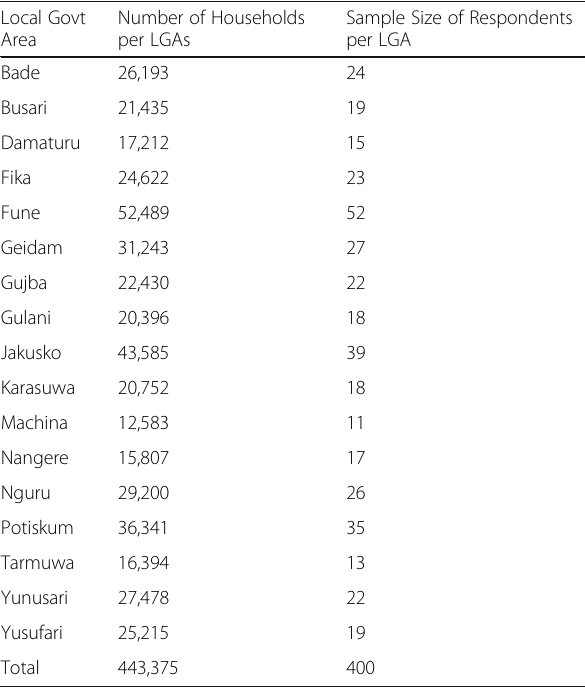
Table 1 Sample Size of the Household Respondents in the Study